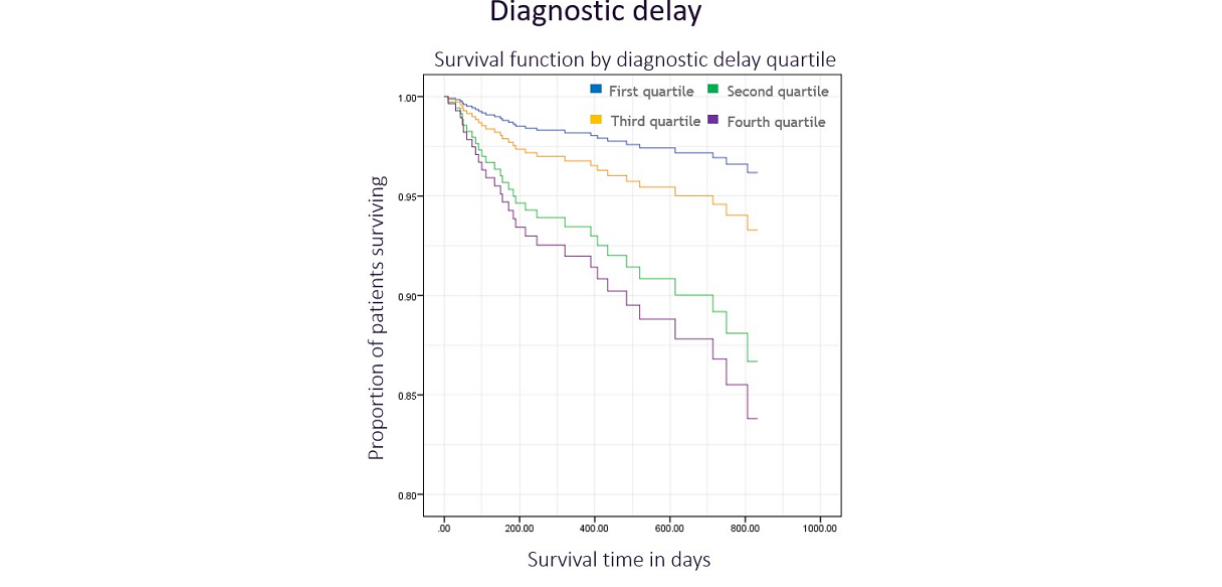
Figure 5. Kaplan-Meier plot illustrating the survival function by diagnostic delay quartile with time.